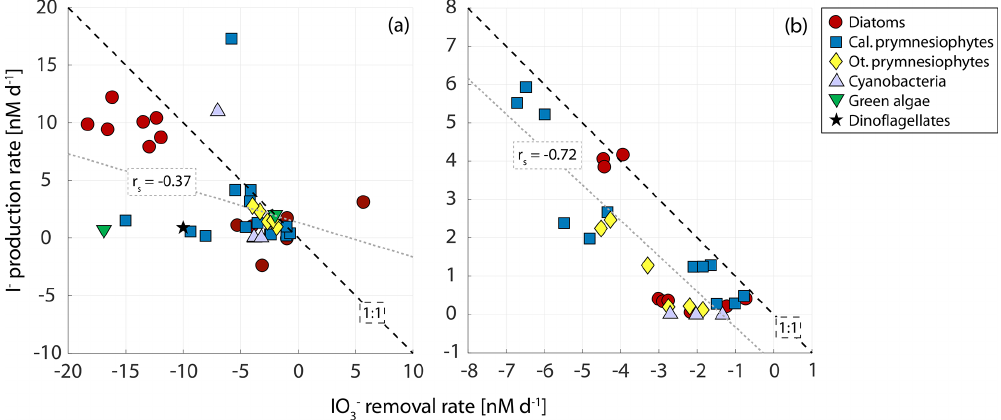
Figure 6. Relationship between (a) IO − removal and I − production rate, including other studies with similar initial IO − concentrations 3 3 (Chance et al., 2007; Wong et al., 2002) during the logarithmic growth phase, and (b) the overall (whole experiment) removal and production rates in the 30 phytoplankton cultures (three cultures per strain) from only this study (note: we were not able to find studies of iodide production that were conducted over all growth phases of the cultures and that additionally were carried out with iodate at ambient levels; thus only our cultures are included). Rates are calculated as the change in the inorganic iodine species normalised to experimental duration. Dashed line is the 1 : 1 line. Grey lines are the least-square lines ( p = 0 . 018, n = 41; p = 0 . 00001, n = 30). The marker symbol gives information on whether the shown culture was a diatom (circle), calcifying prymnesiophyte (square), other prymnesiophytes (diamond), cyanobacteria (upward-pointing triangle), green algae (downward-pointing triangle) or dinoflagellate (star). Note that the calcifying prymnesiophyte outlier in (a) is from Chance et al. (2007), in which the I − production rate for Emiliania huxleyi (CCMP 373) in the log phase was calculated over the course of fewer days than the IO − consumption rate due to loss of I − during the log 3